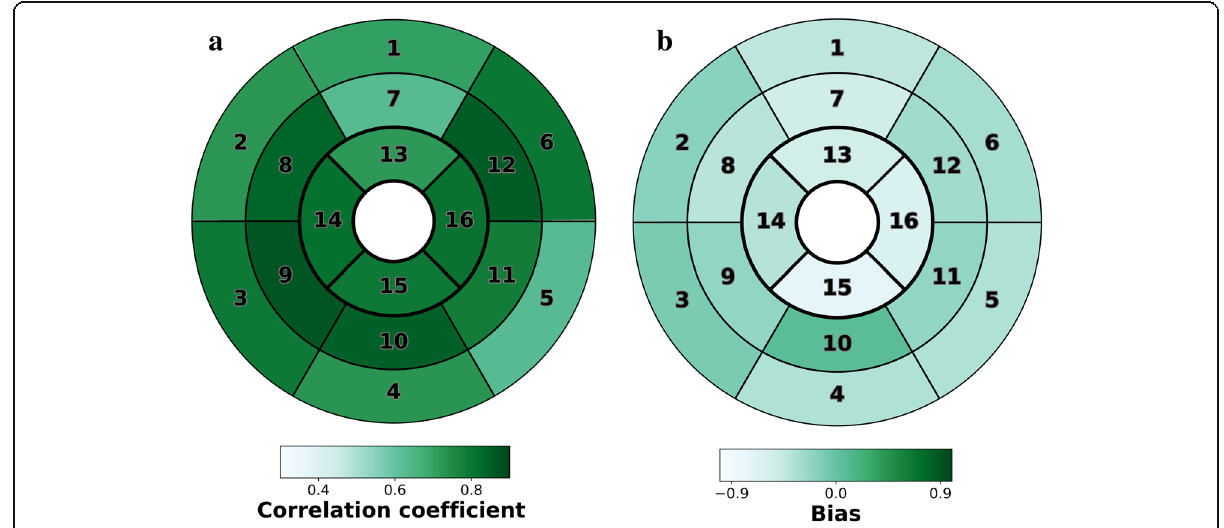
Fig. 3 Quantitative regional wall motion correlation and agreement between accelerated k-t SENSE and 2D-SSFP images. 16-Segment American Heart Association bullseye plots indicate the correlation coefficients ( a ) and mean differences or bias ( b ) (in mm) for wall motion assessed by accelerated k-t SENSE and 2D-SSFP cine